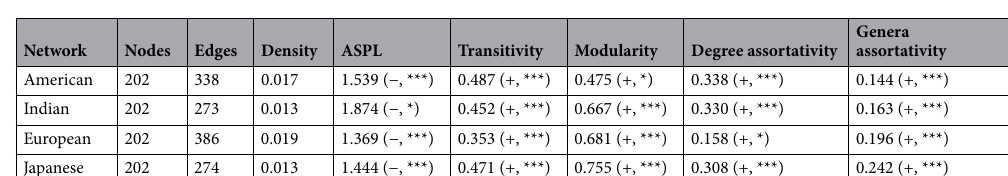
Network Nodes Edges Density ASPL Transitivity